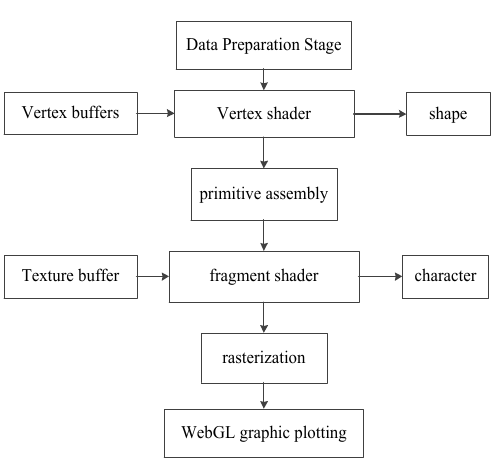
Figure 7. Rendering processing flow